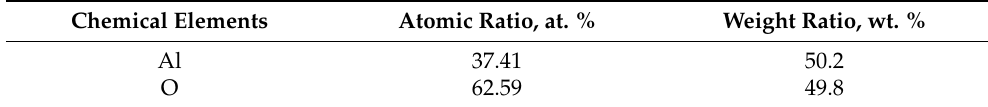
Table 8. Chemical analysis of Al 2 O 3 sample at the fracture.